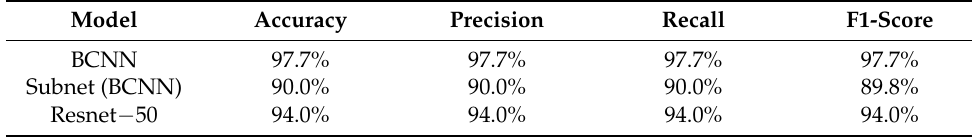
Figure 4. ( A ) Confusion matrix for “halo cell” detection. ( B ) Area under the curve (AUC) and receiver operating characteristic (ROC) analysis of “halo cell” detection by our BCNN model. ( C ) Comparison of ROC/AUC performance of the BCNN with that of two other deep learning models. Table 1. Performance evaluation of different deep learning